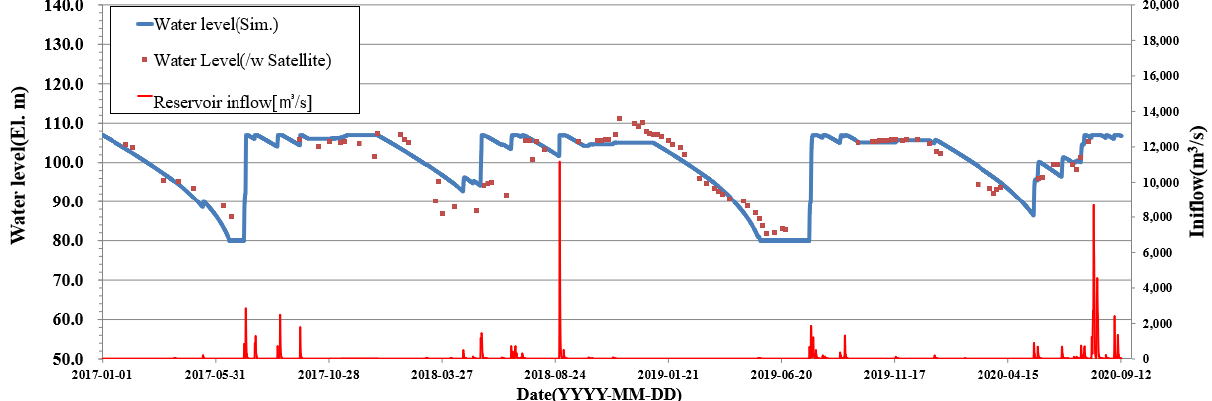
Figure 11. The continuous simulation of the water level using the Auto ROM algorithm for the Hwanggang Dam reservoir; the blue line represents the water level variability from the reservoir operation method; the red dot represents the water level derived by Sentinel-2 images; the red line represents the dam inflow from the rainfall – runoff model. Table 5. The operational conditionsfor the Auto ROM algorithm for the Hwanggang Dam reservoir.